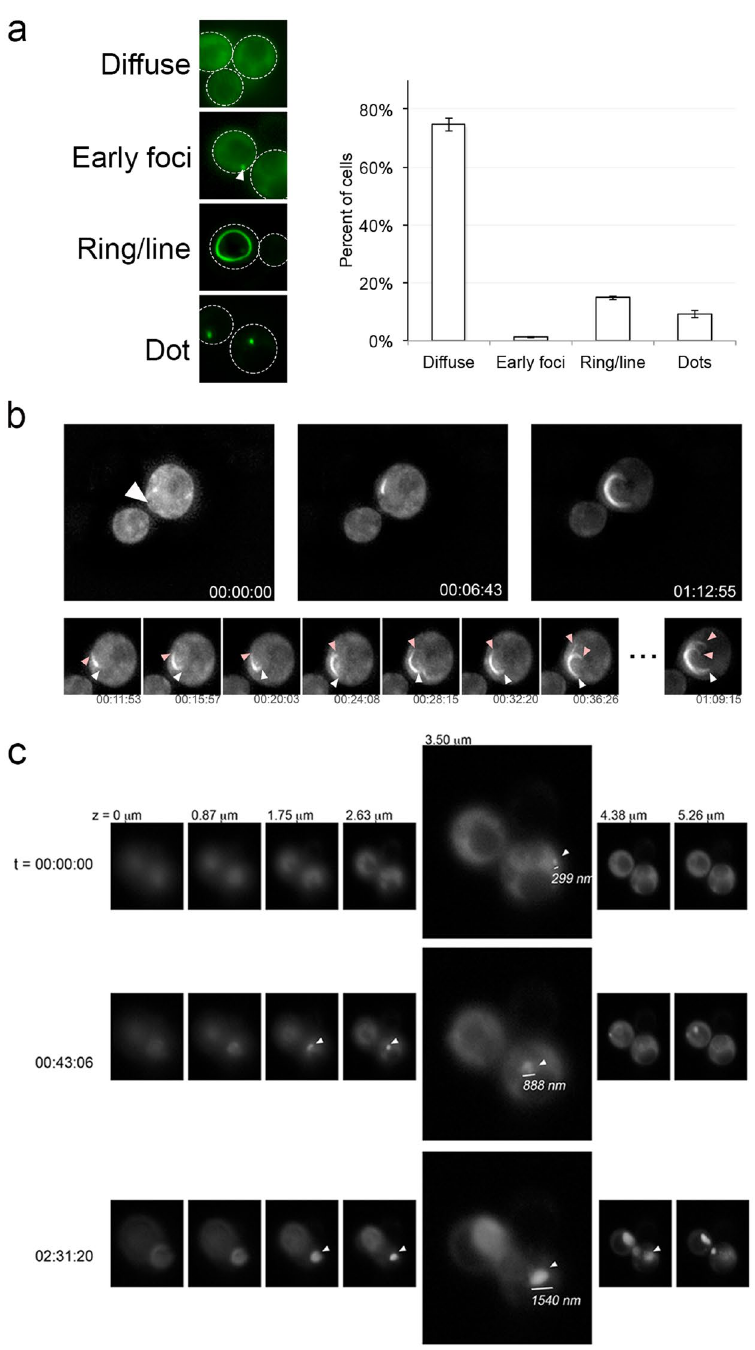
Figure 1. Formation of fluorescent structures begins as an early focus and develops into line and dot structures with distinctive growth patterns. ( a ) Sup35PrD-GFP was overexpressed in [ psi − ][ PIN + ] strains for approximately 18 hours. Cells were categorized as having diffuse cytoplasmic fluorescence (diffuse), the presence of a small focus/several foci on a diffuse background (early foci; indicated with arrow), rings/lines, or dots. The percentage of cells containing each fluorescent structure was determined by counting more than 700 cells from 3 independent transformants. Standard error is shown. ( b ) After 18 hours of overexpression, diffuse cells were visualized for an additional 12 hours using 3D time-lapse microscopy. Early foci (left top panel, arrow), mid (middle panel), and late stages (right panel) of ring formation (time shown as HH:MM:SS) relative to the first appearance of early focus are shown. The lower panel shows a more detailed time-lapse, with different colored arrows (white and pink) indicating different ends. All images shown are maximum projection. ( c ) Z-stacks (indicated as μ m), corresponding to specific time points (rows), is shown for a single cell forming a single focus over time. 3.5 μ m is expanded for more detail. The diameter of the growing dot structure was measured, as indicated by representative line. Arrows indicate when the focus is visible in each